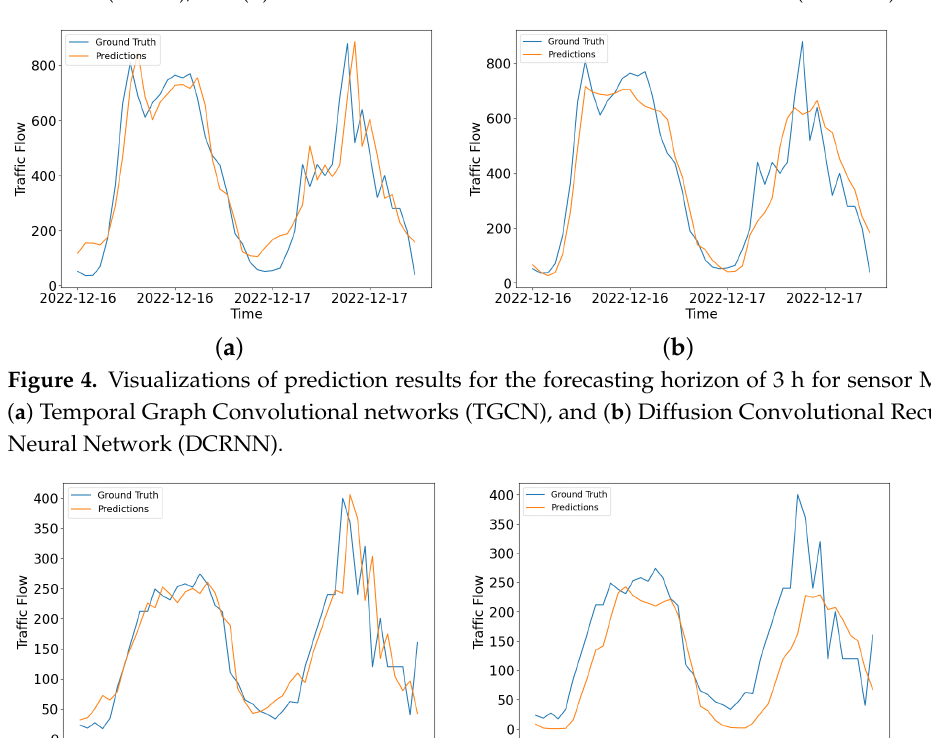
Figure 3. Learning curves with training and validation error for: ( a ) Temporal Graph Convolutional networks (TGCN), and ( b ) Diffusion Convolutional Recurrent Neural Network (DCRNN).